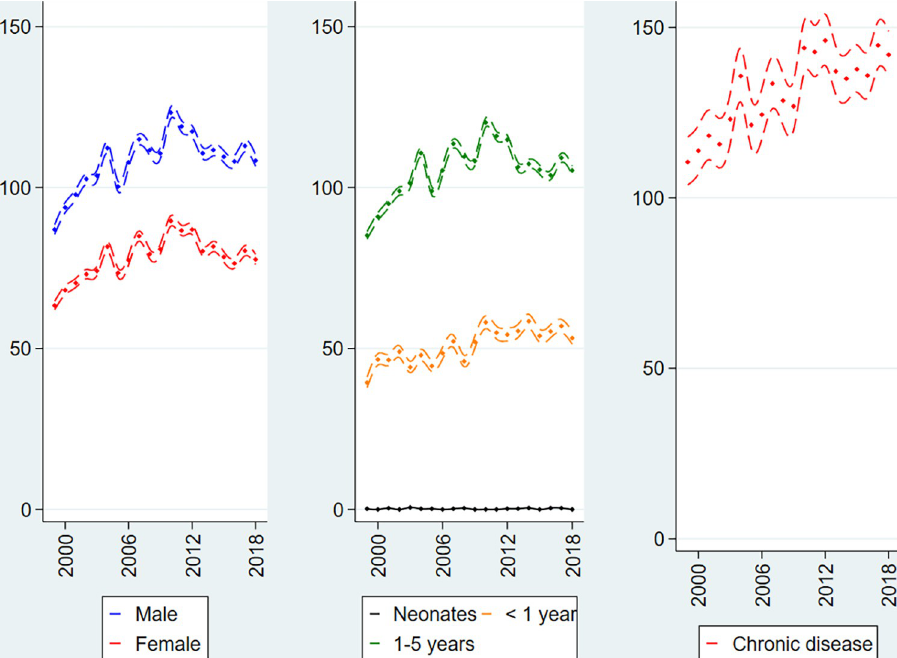
Fig 3. General anaesthesia in private specialist practice per 1000 person-years in Danish children 0–5 years of age, 1999–2018. Sex-specific incidence (left panel), age-specific incidence (middle panel) and chronic disease-specific incidence (right panel) with 95% pointwise confidence